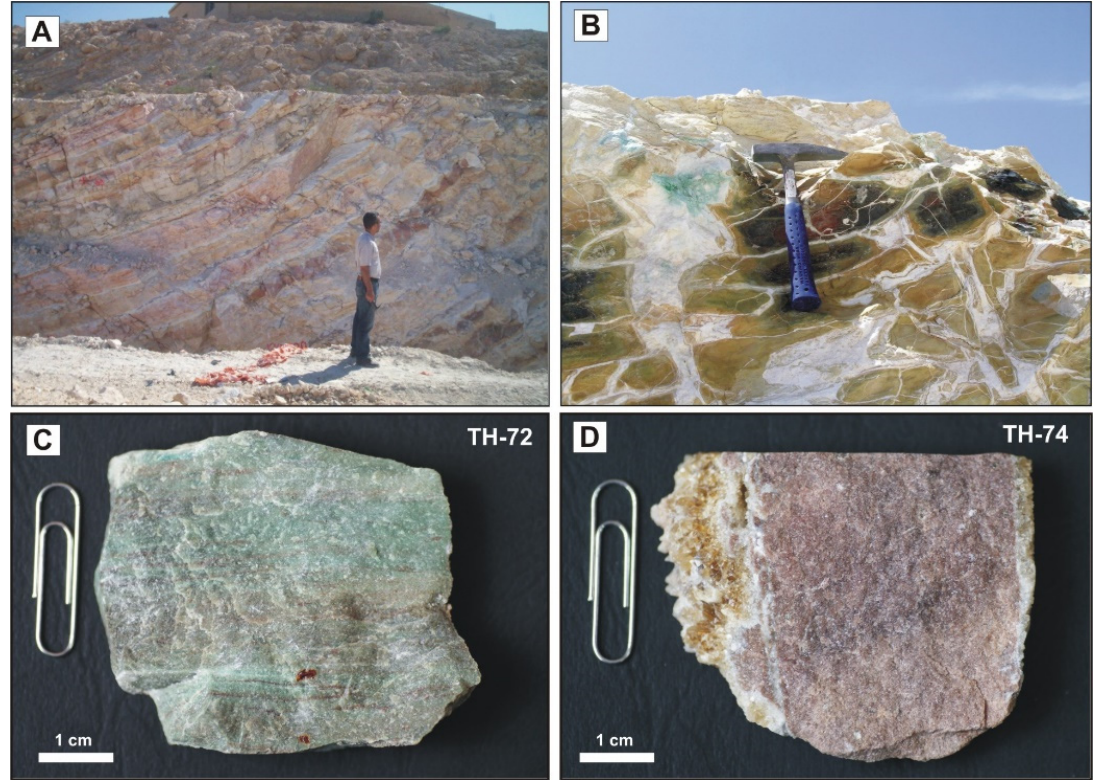
Figure 3. The varicolored marbles from Daba-Siwaqa complex (central Jordan). ( A ) Exposures of varicolored marbles with the original textural features of precursory sediments, after [18]. ( B ) Varicolored marbles with strong retrograde alteration. ( C ) Sample of spurrite-fluorapatite marble with abundant primary Zn-bearing oxide compounds. ( D ) Sample of ZnS-bearing fluorapatite marble.